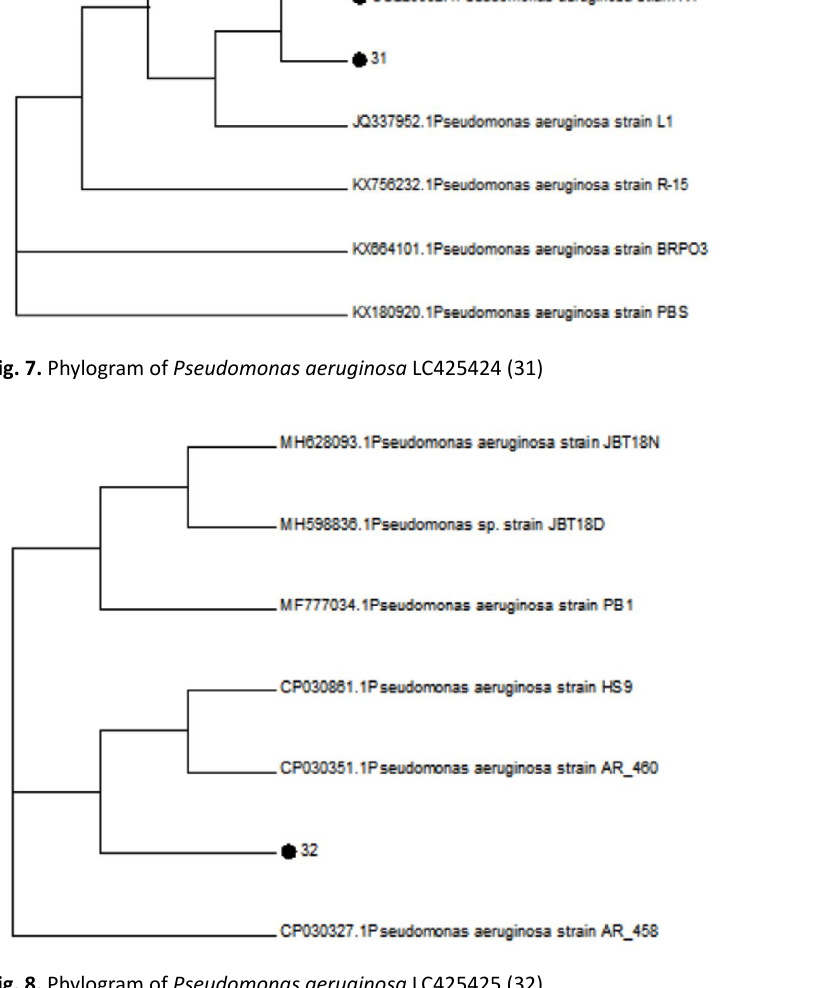
Fig. 8. Phylogram of Pseudomonas aeruginosa LC425425